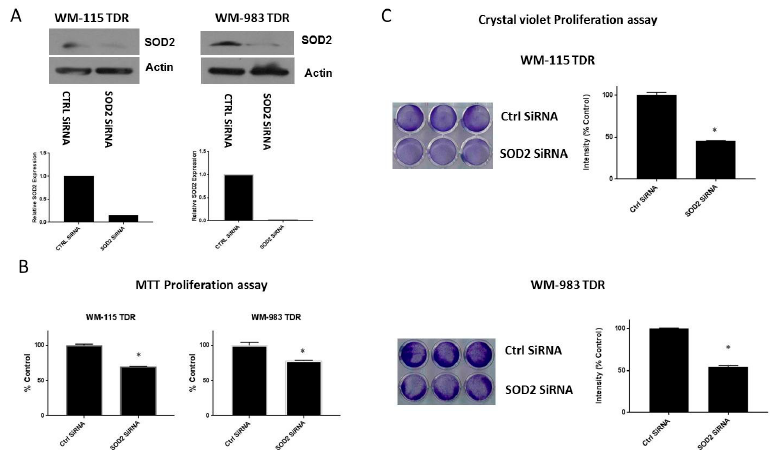
Figure 5. Knockdown of SOD2 reduces growth in BRAF pathway inhibitor-resistant cells. ( A ) WM-115 TDR and WM-983 TDR cells were transfected with a SOD2 specific siRNA or control (siCon) for 48 h and analyzed using specific antibodies. Actin served as the loading control. Densitometric analysis of SOD2 expression was normalized to Actin. ( B ) Both WM-115 TDR and WM-983 TDR cells transfected with Con siRNA and SOD2 siRNA cells were plated in triplicate in 96 well plates for 72 h. ( C ) Both WM-115 and WM-983 TDR cells transfected with Con siRNA and SOD2 siRNA (30,000 cells / well) were plated in triplicate, as indicated. * p < 0.05 vs. CTRLsiRNA. Statistical analysis by one way ANOVA. Cancers 2020 , 12 ,